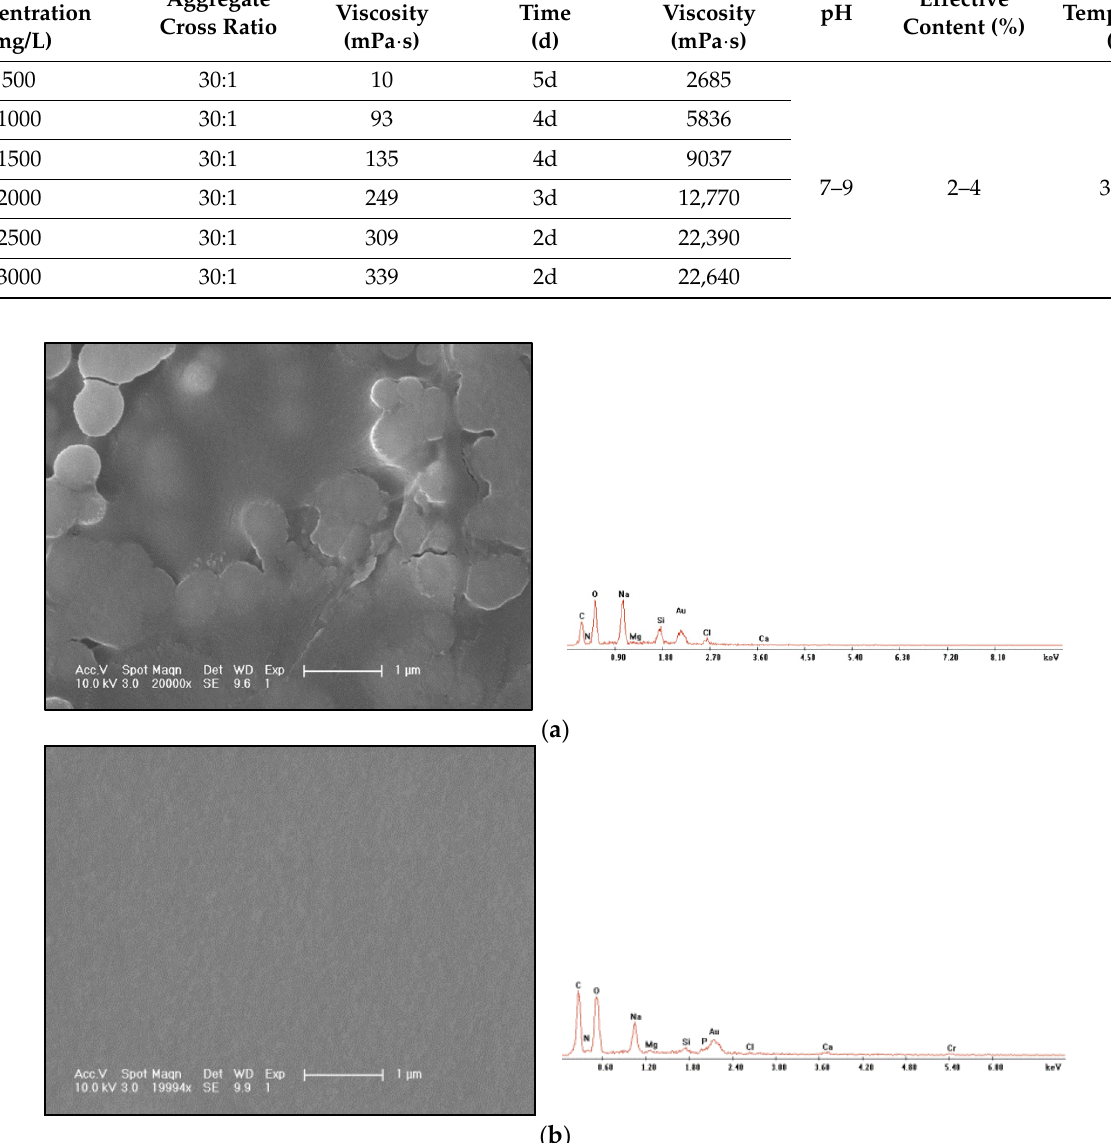
Figure 5. Freeze-drying SEM photos and EDS energy spectrum. ( a ) Polyacrylamide solution. ( b ) Polyacrylamide chromium gel.